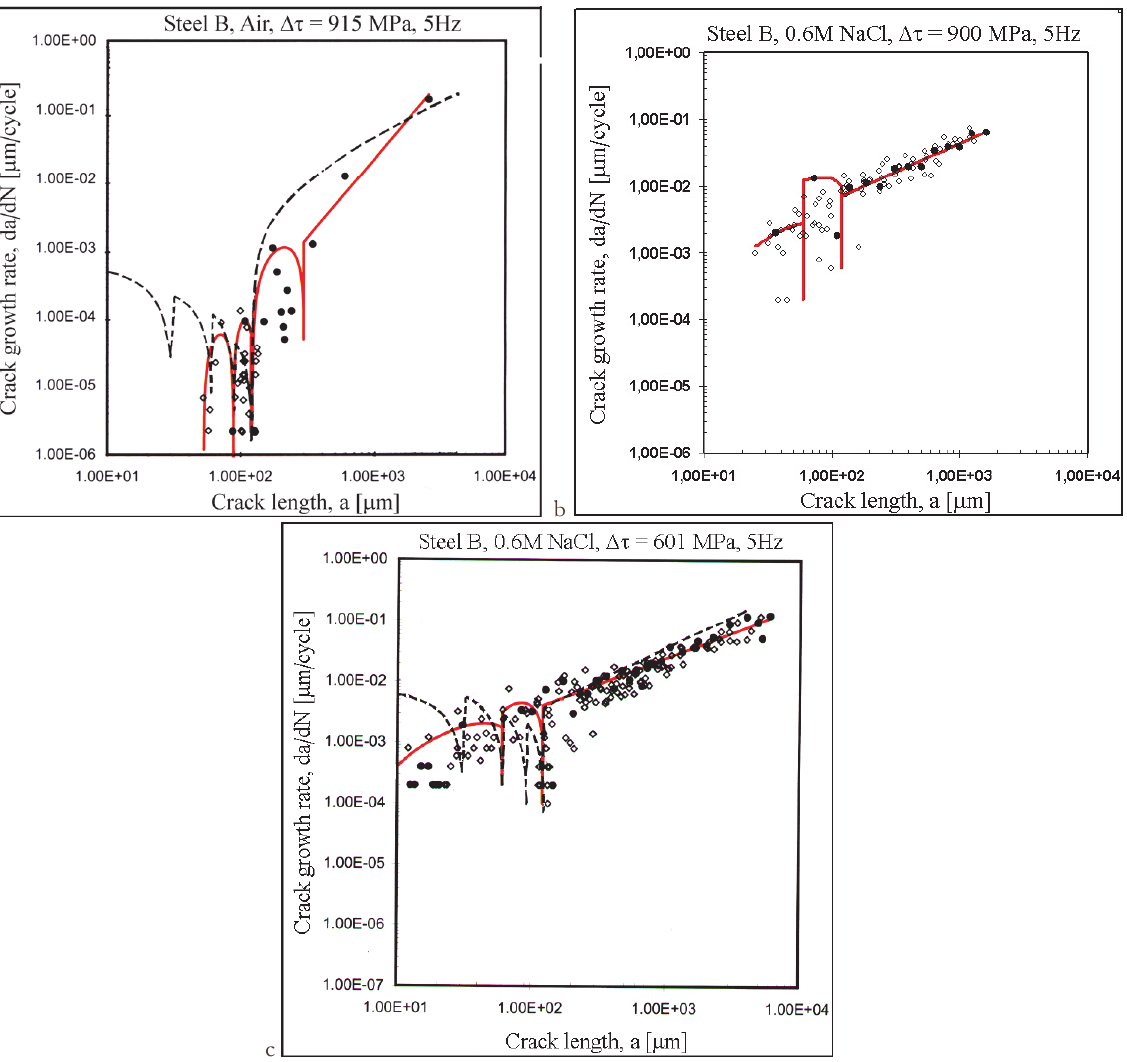
Figure 4: Fatigue crack growth curves for Steel B: (a) air; (b), (c)